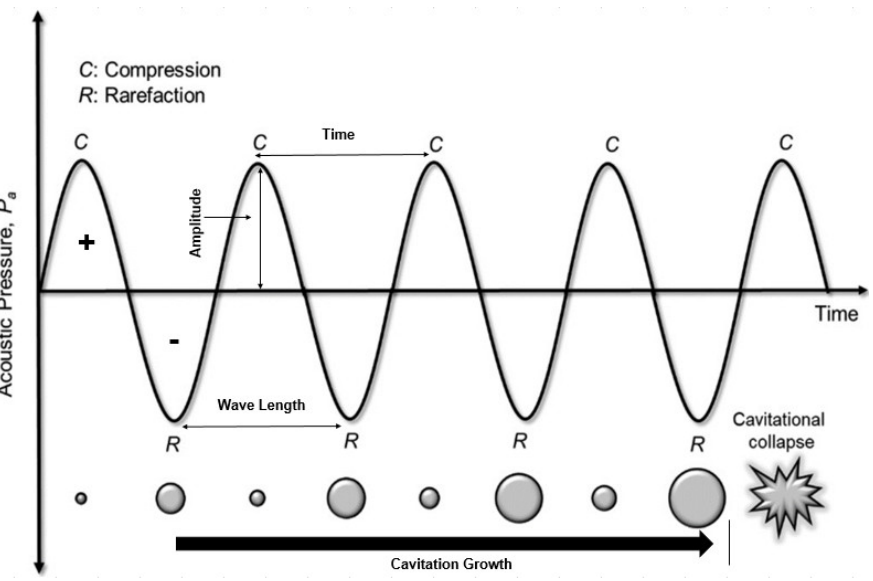
Figure 9. Ultrasound cavitation stages: acoustic cavitation, cavitation growth, and collapse [24] (Permission No. 5322081328929).